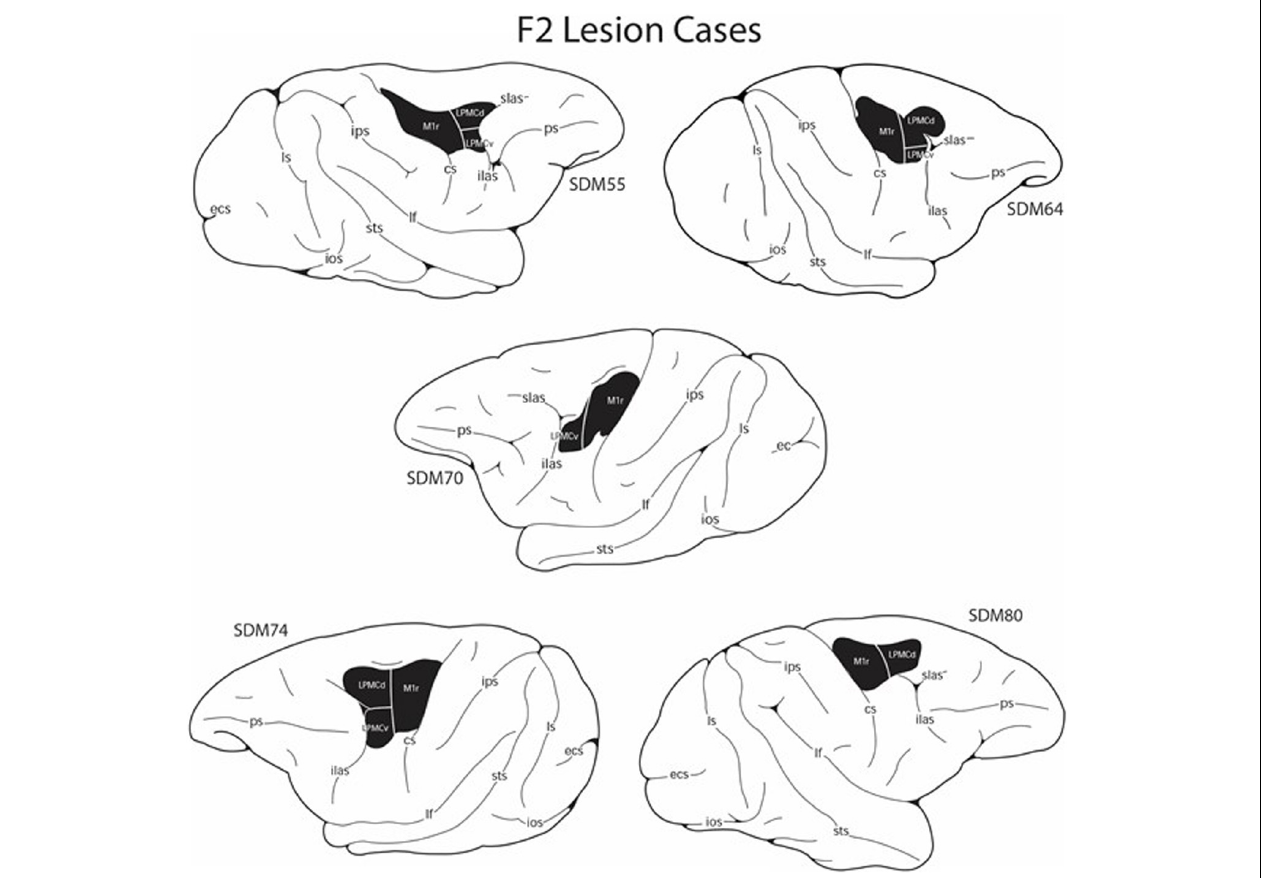
FIGURE 1 | Line drawings of the lateral surface of the cerebral cortex showing the M1 + LPMC lesion site locations (blackened area) in the five F2 lesion cases. Detailed descriptions of the histological and cytoarchitectonic characteristics of each lesion are provided in previous reports along with microstimulation maps of the cortical surface that were used to guide the placement of each lesion (Darling et al., 2009; McNeal et al., 2010). cs, central sulcus; ecs, ectocalcarine sulcus; ilas, inferior limb of the arcuate sulcus; ios, inferior occipital sulcus; ips, intraparietal sulcus; lf, lateral fissure; ls, lunate sulcus; ots, occipito-temporal sulcus; ps, principal sulcus; slas, superior limb of the arcuate sulcus; sts, superior temporal